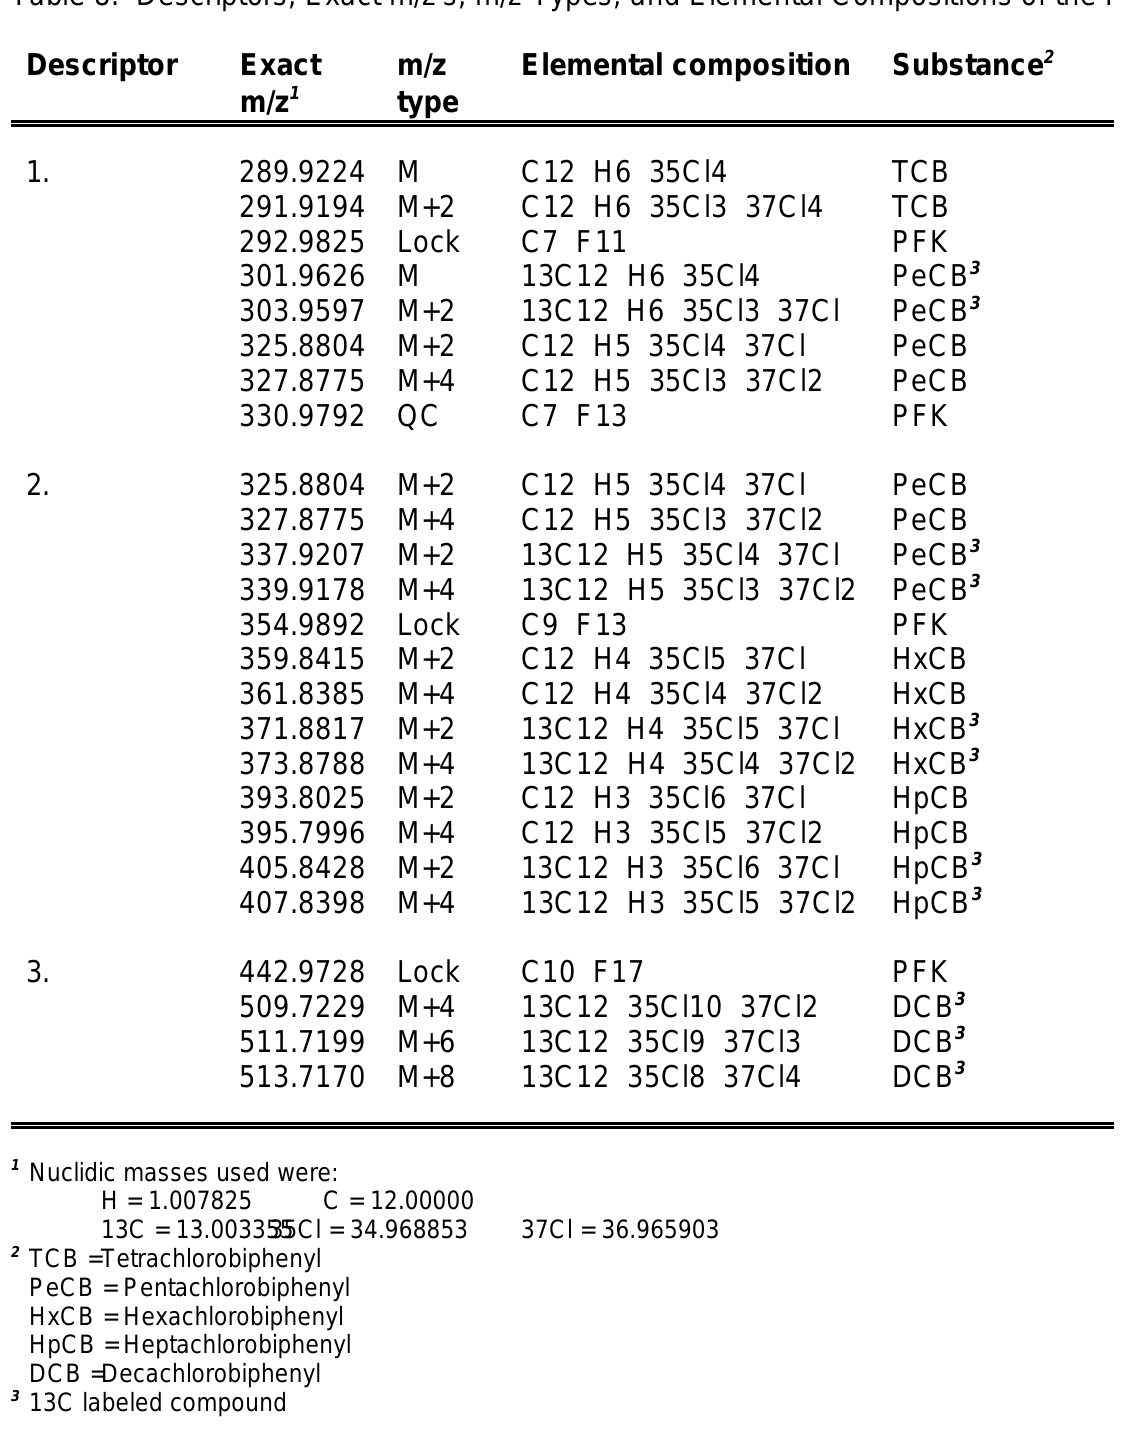
Table 8. Descriptors, Exact m/z's, m/z Types, and Elemental Compositions of the